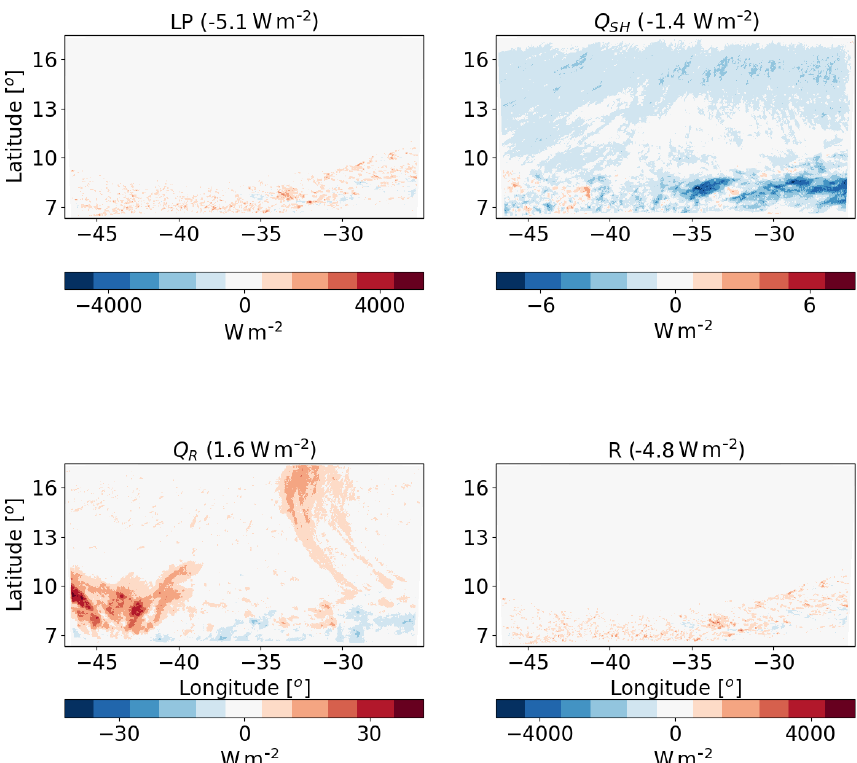
Figure 6. The differences between polluted (CDNC = 200cm − 3 ) and clean (CDNC = 20cm − 3 ) ICON simulations of the time-mean terms of the energy budget for the shallow-cloud-dominated case (10–12 August 2016). The terms that appears here are as follows: LP – latent heat by precipitation, Q SH – sensible heat flux, Q R – atmospheric radiative warming – and R – the energy imbalance. The domain- and time-mean value of each term appear in